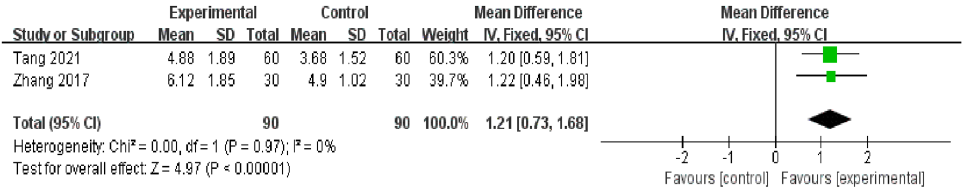
Figure 7. Artificial tears vs. Artificial tears plus Auricular acupressure on TBUT [51,52]. SIT